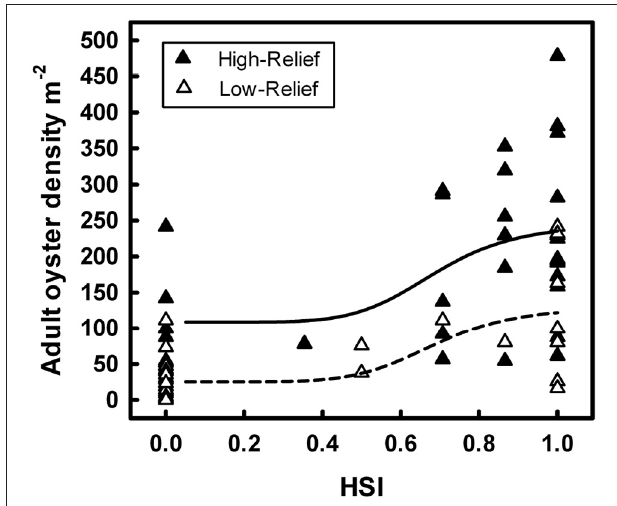
FIGURE 13 | Sigmoidal relationships between habitat suitability index score and associated live adult oyster density on high-relief and low-relief reefs of eastern oyster Crassostrea virginica in the Great Wicomico River, a western shore tributary of lower Chesapeake Bay. Figure reproduced with